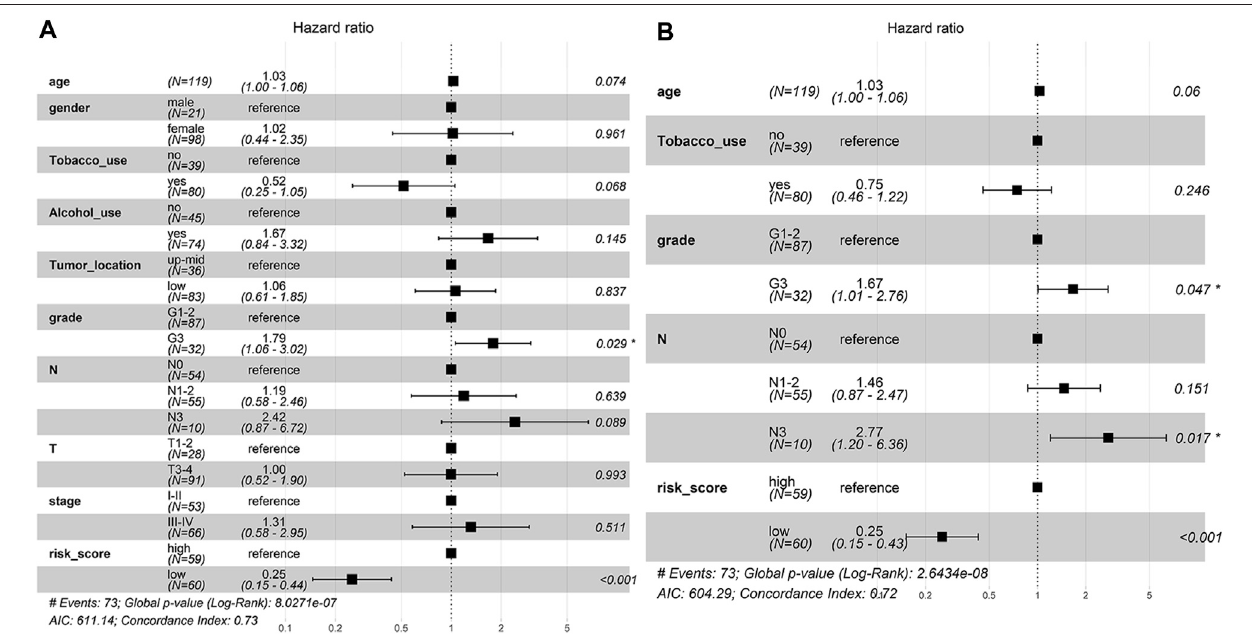
FIGURE 4 | The independent prognostic factors for ESCC OS. (A) Univariate Cox regression analysis for assessment of the prognostic values of different clinicopathological characteristics and the risk score. (B) Evaluation of the independency of the risk score and other factors for predicting the prognosis of ESCC using multivariate Cox regression